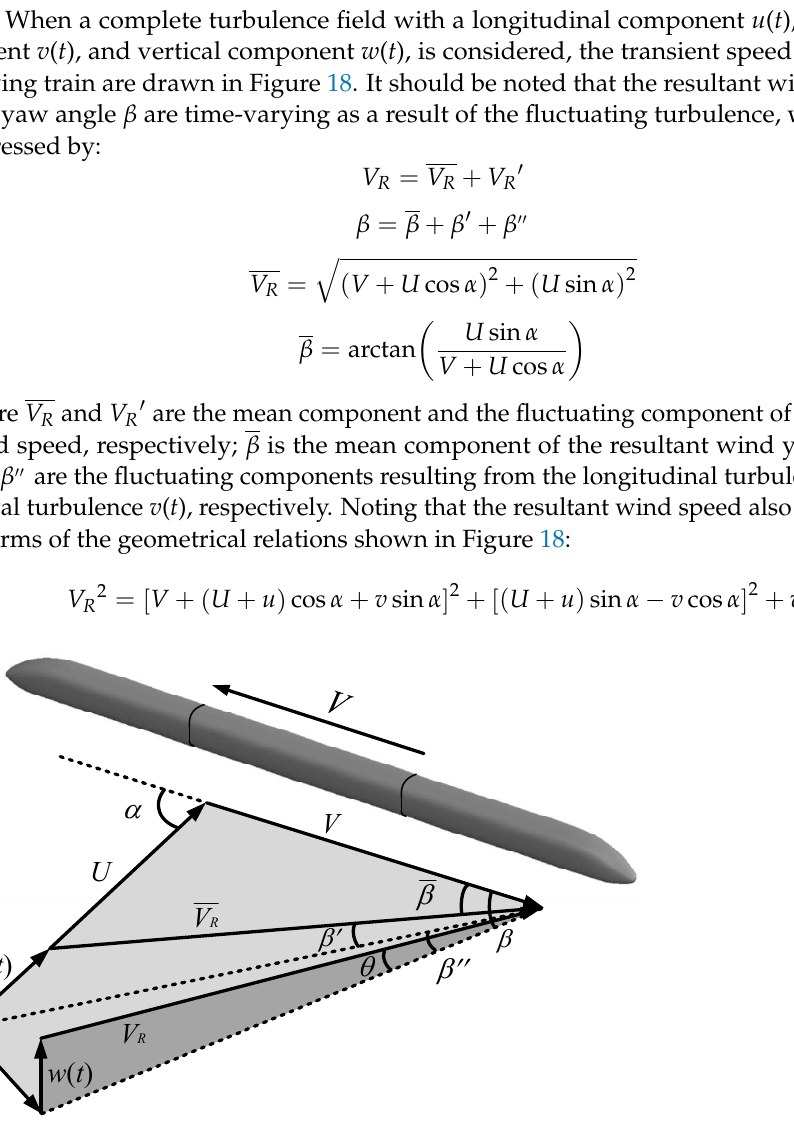
Figure 18. Transient speed vectors on a moving train in a competed turbulence field.